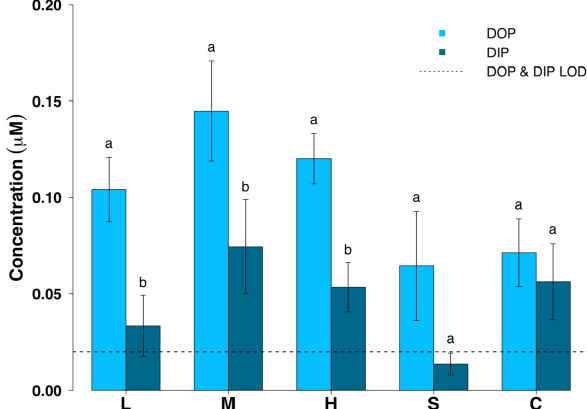
Figure 4. Dissolved organic phosphorus (DOP) and dissolved inor- ganic phosphorus (DIP) concentrations for all surface ice habitats (mean ± SE, n = 19 for L, M, H, n = 10 for S and n = 14 for C). L – ice with low visible impurities, M – ice with medium visible impurities, H – ice with high visible impurities, S – supraglacial stream water and C – cryoconite hole water. The LoD line depicts the limit of detection of the instrument. Lowercase letters denote t test comparisons in relation to habitat